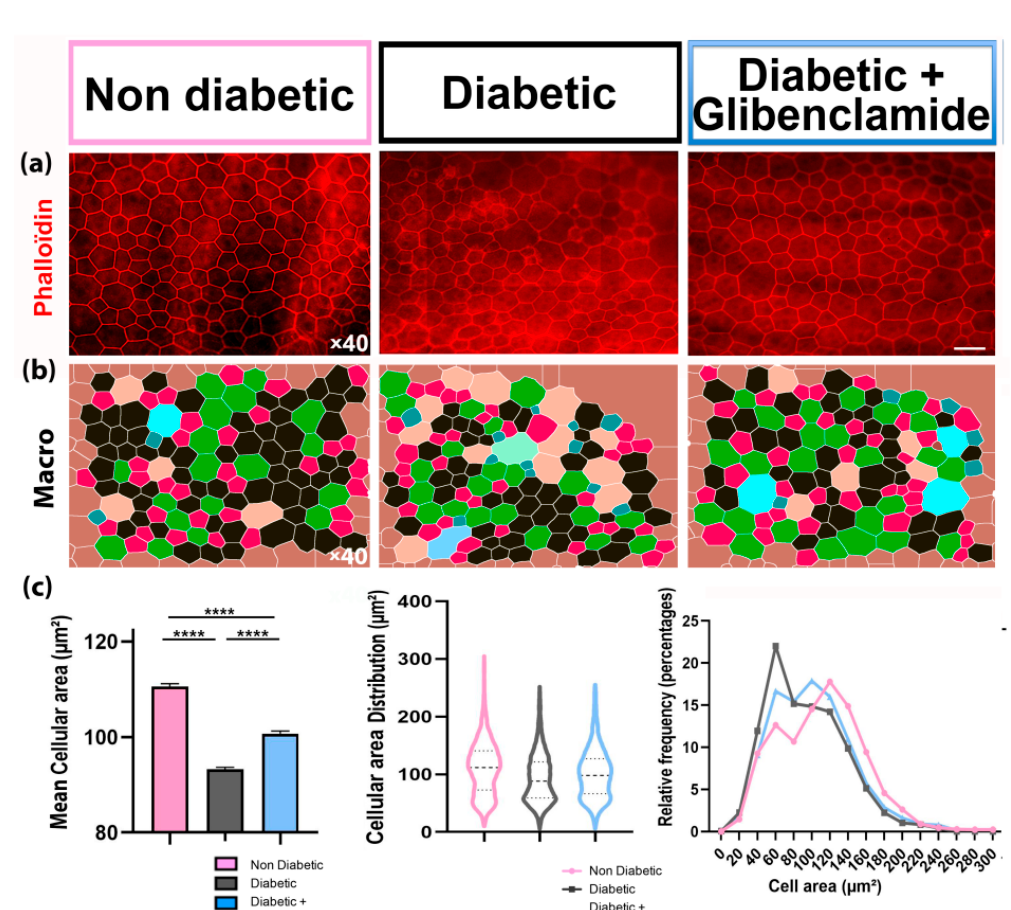
Figure 5. Long-term low-dose oral glibenclamide treatment protects RPE against diabetes-induced change in diabetic Goto-Kakizaki rats. ( a ) Retinal pigment epithelium flatmounts of 1-y-old non-diabetic female, diabetic and glibenclamide- treated diabetic rats; immunohistochemistry with anti-phalloïdin antibody and fluorescence microscope pictures ( × 40); bar = 40 µ m; ( b ) morphological analysis of those RPE pictures with a home-made macro in ImageJ software; ( c ) mean RPE cellular area ( µ m 2 ) ± SEM (left; ANOVA p < 0.0001 followed by Dunn’s post-test **** p < 0.0001; n = 5983, 10,294 and 6232 cells of 7, 4 and 4 eyes, respectively); distribution of cell areas (middle); relative frequency of cell areas (right) in each group: non diabetic control wistar + female GK rats = pink bar, violin and line; diabetic GK rats = grey bar, violin and line; glibenclamide-treated diabetic GK rats = blue bar, violin and